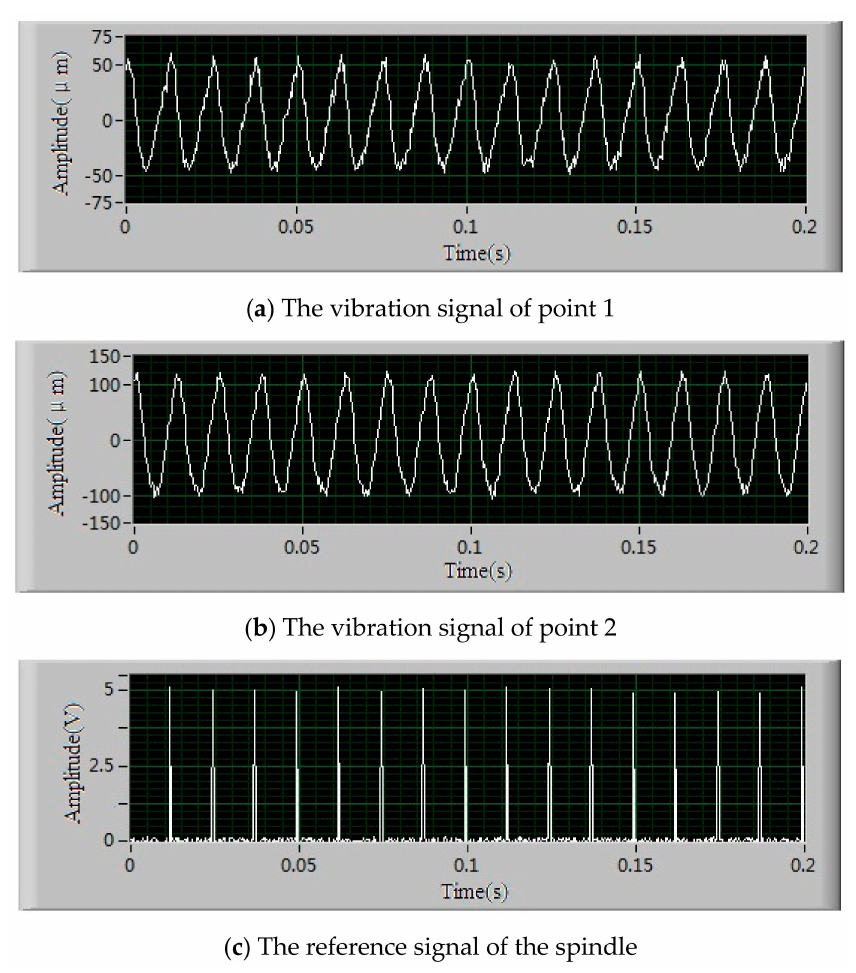
Figure 11. The original vibration signals and reference signal of the spindle after the second trial